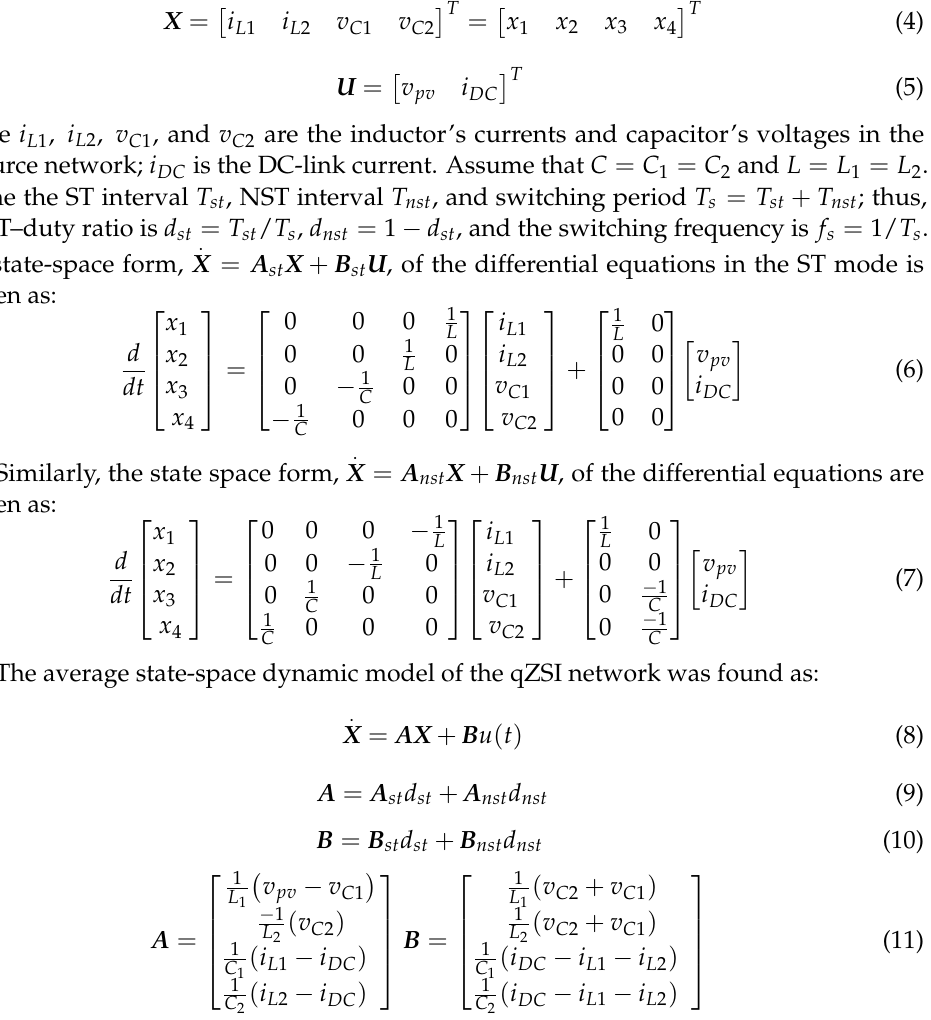
Figure 5. Equivalent circuits of the qZSI ( a ) in a non-shoot-through state and a ( b ) shoot-through